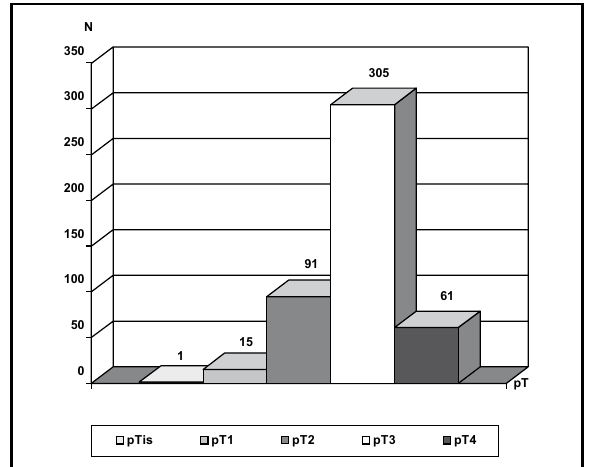
querdo manteve-se idêntica ao longo do período